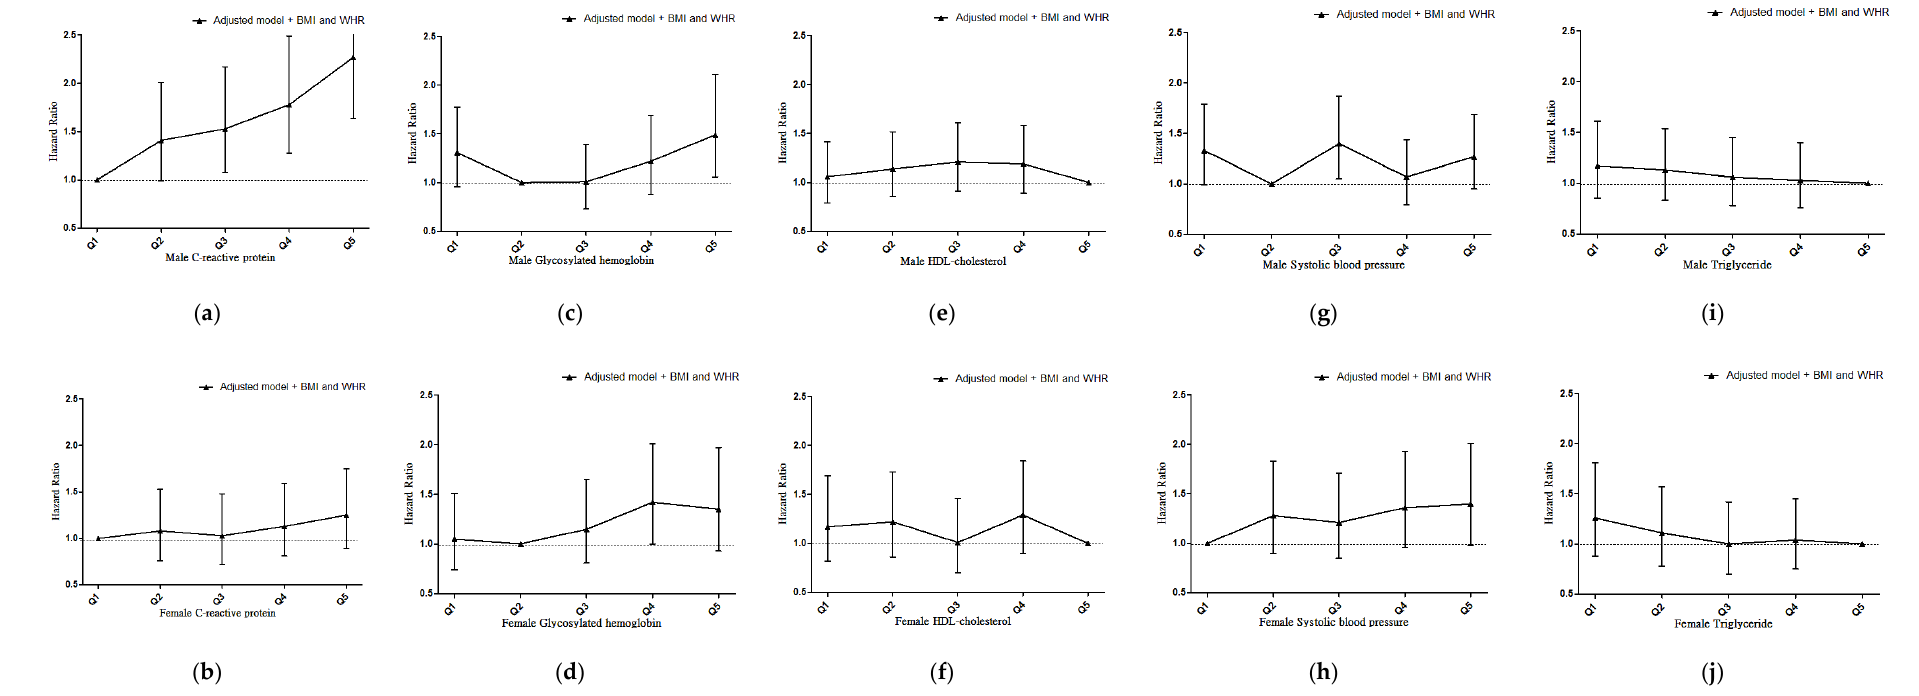
Figure 4. ( a ) HRs for mortality according to C ‐ reactive protein in male patients after adjustment by BMI and WHR; ( b ) HRs for mortality according to C ‐ reactive protein in female patients after adjustment by BMI and WHR; ( c ) HRs for mortality according to glycosylated hemoglobin in male patients after adjustment by BMI and WHR; ( d ) HRs for mortality according to glycosylated hemoglobin in female patients after adjustment by BMI and WHR; ( e ) HRs for mortality according to HDL ‐ cholesterol in male patients after adjustment by BMI and WHR; ( f ) HRs for mortality according to HDL ‐ cholesterol in female patients after adjustment by BMI and WHR; ( g ) HRs for mortality according to systolic blood pressure in male patients after adjustment by BMI and WHR; ( h ) HRs for mortality according to systolic blood pressure in female patients after adjustment by BMI and WHR; ( i ) HRs for mortality according to triglyceride in male patients after adjustment by BMI and WHR; ( j ) HRs for mortality according to triglyceride in female patients after adjustment by BMI and WHR. Adjusted model: adjusted for age, gender, eGFR, Upcr log, diabetes, cardiovascular disease, smoker, cancer, severe liver disease, hypertension, hemoglobin, cholesterol log, glycosylated hemoglobin, albumin, CRP ln and phosphorus. Abbreviations: BMI: body mass index, WHR: waist ‐ to ‐ hip ratio.